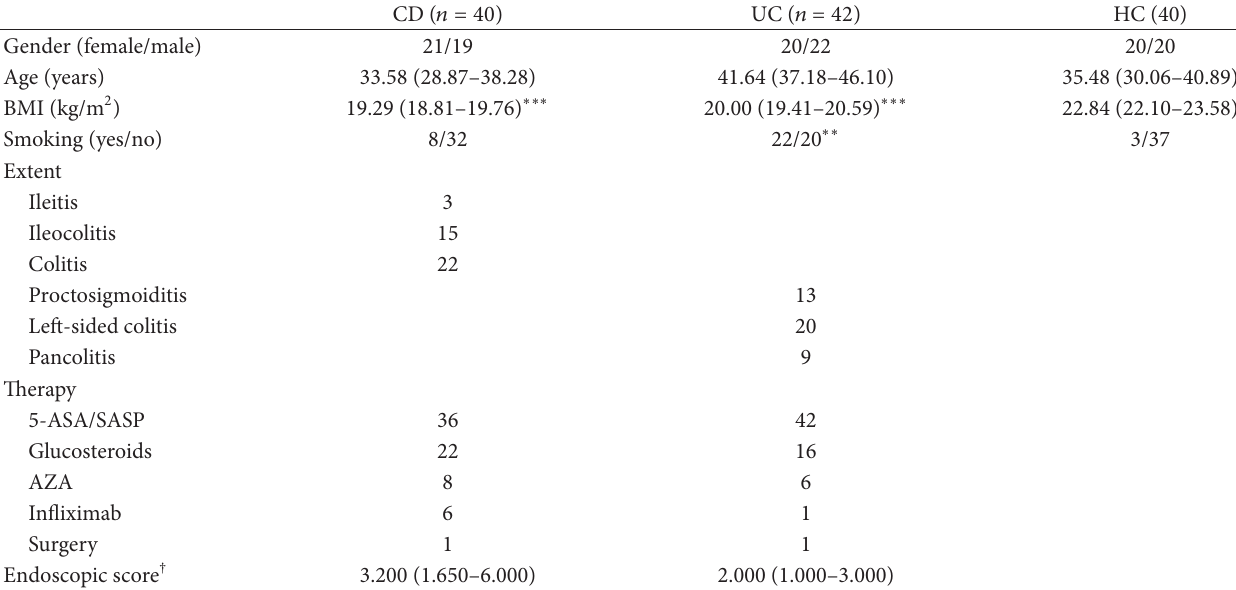
T 1: Characteristics of included